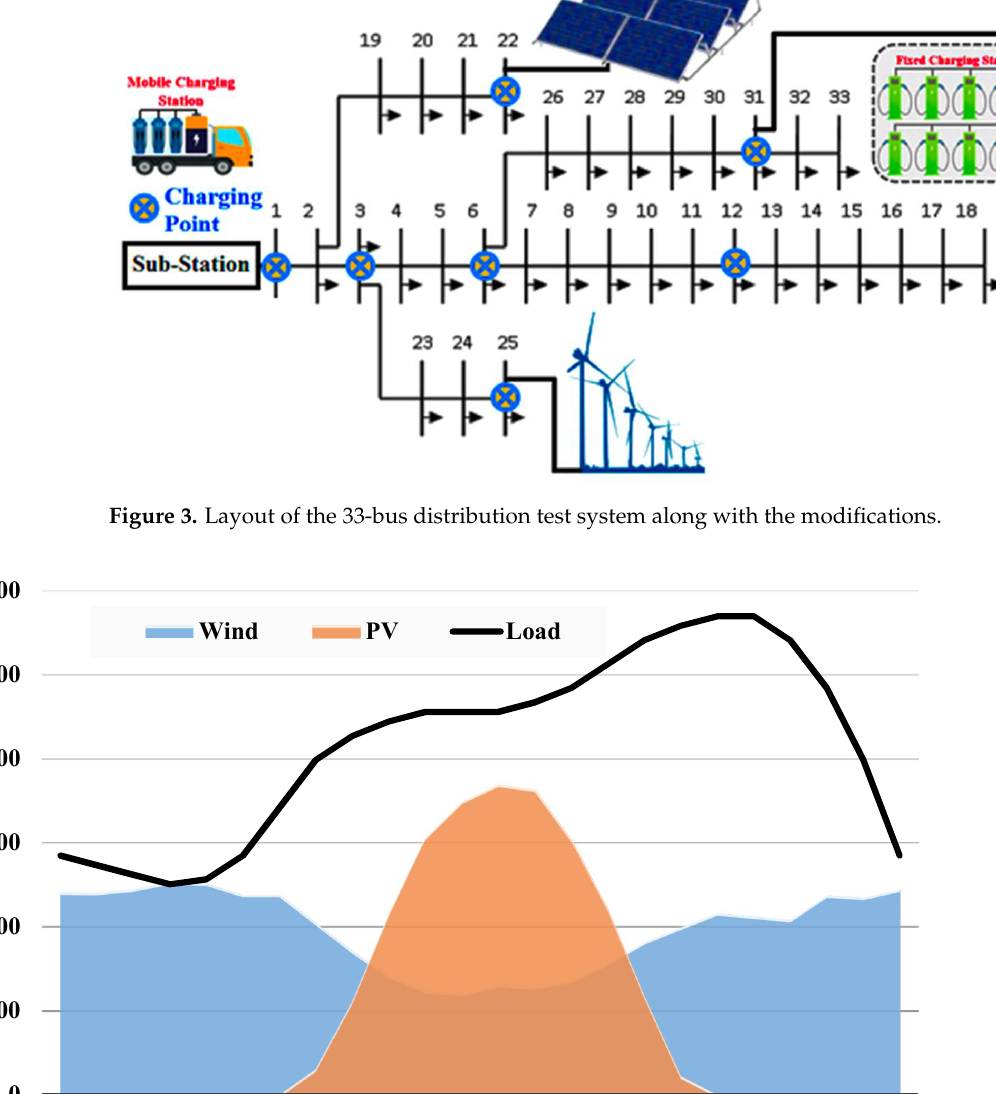
Figure 4. Hourly power generation for wind and PV resources.